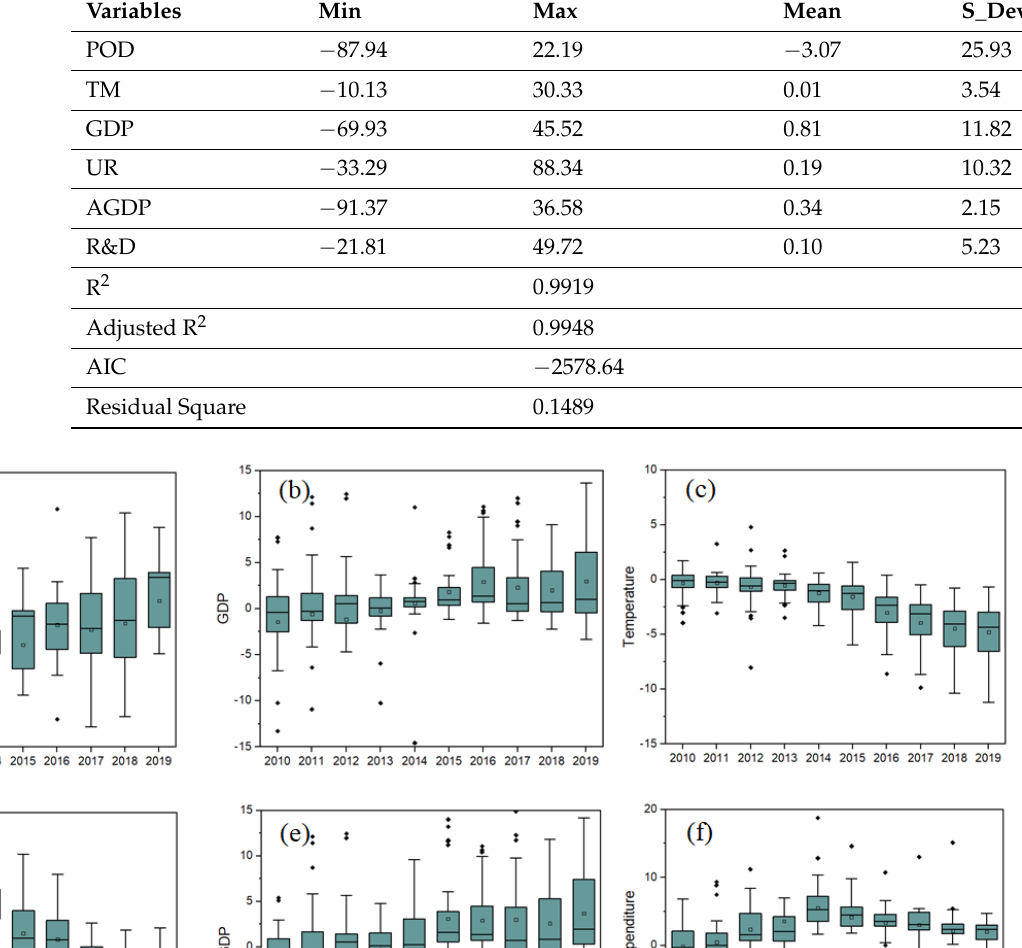
Table 4. The estimation results of the GTWR parameter.